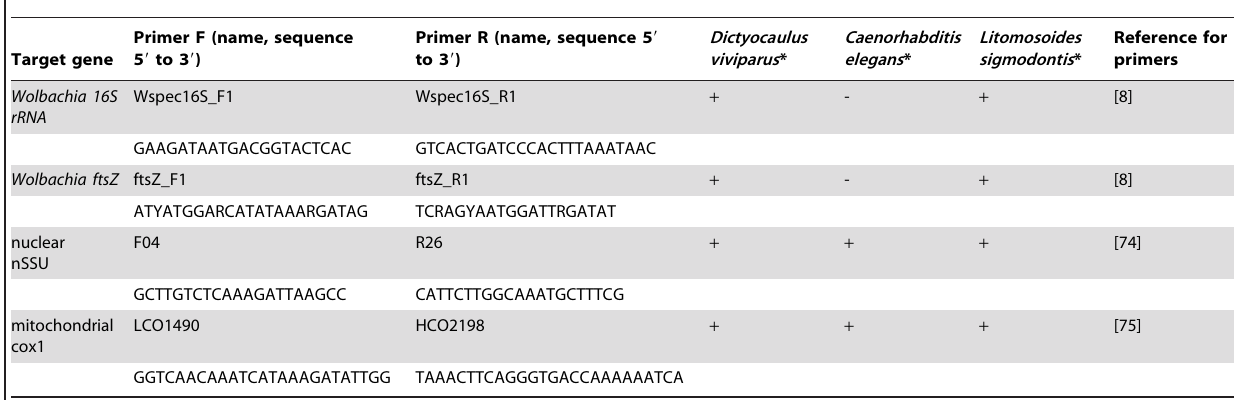
Table 7. PCR test for Wolbachia